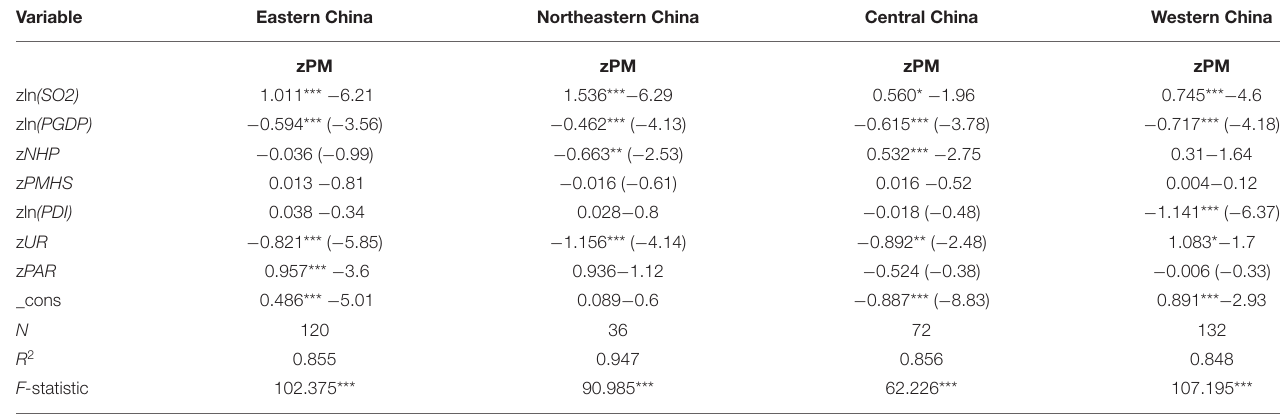
TABLE 6 | Heterogeneity analysis results.